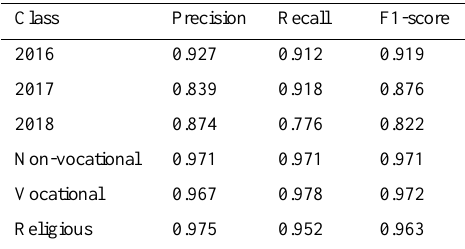
Table 6. Adaptive model performance on test dataset